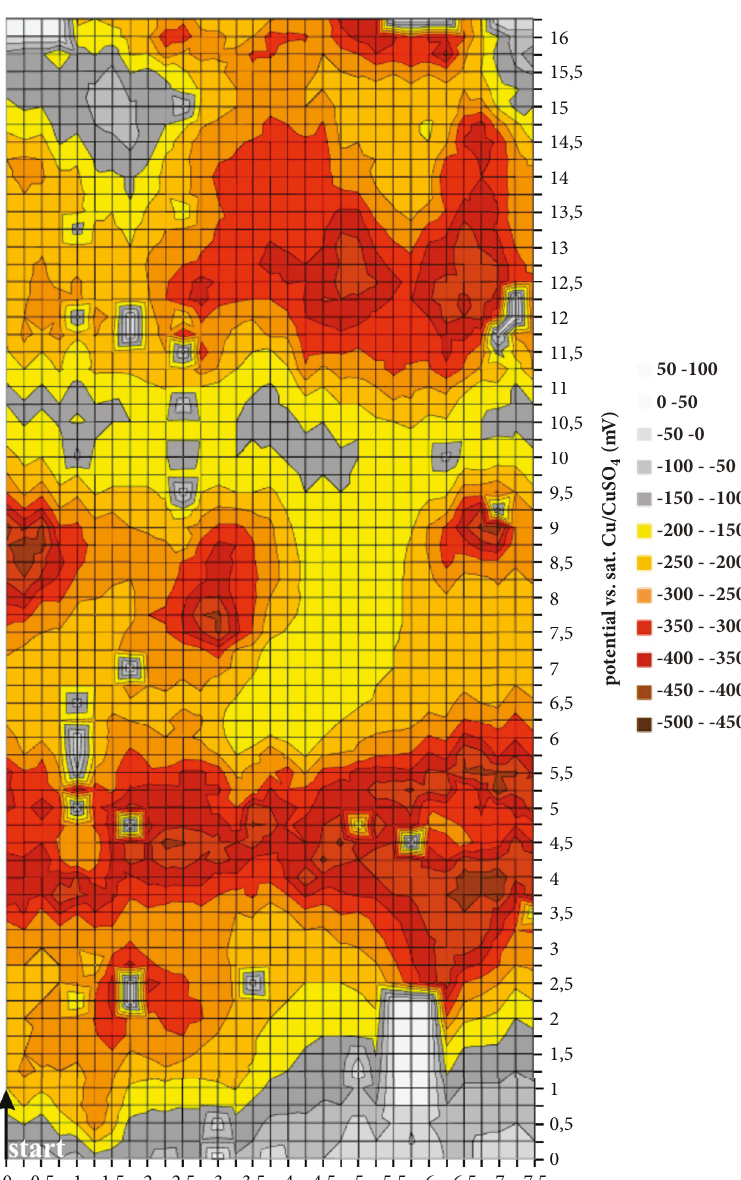
Figure 3: Graphical representation of measured potential field of a concrete slab.